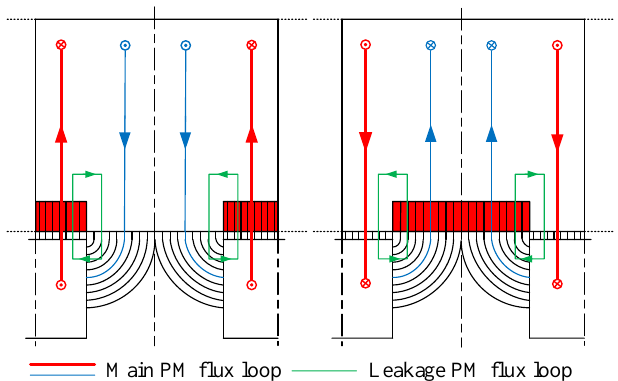
Figure 4. Air-gap-equivalent magnetic reluctance of proposed TF − CFRM.